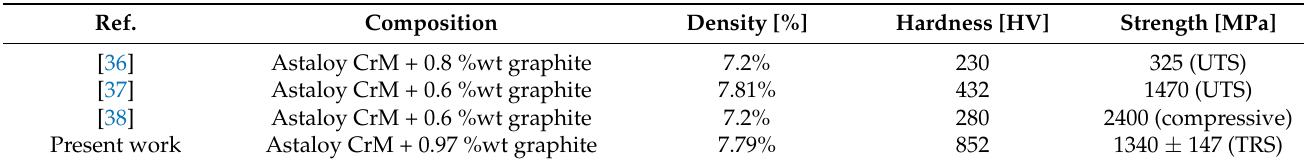
Table 4. Literature data of powder metallurgical materials deriving from admixed Astaloy CrM powders, compacted through press and sinter techniques.